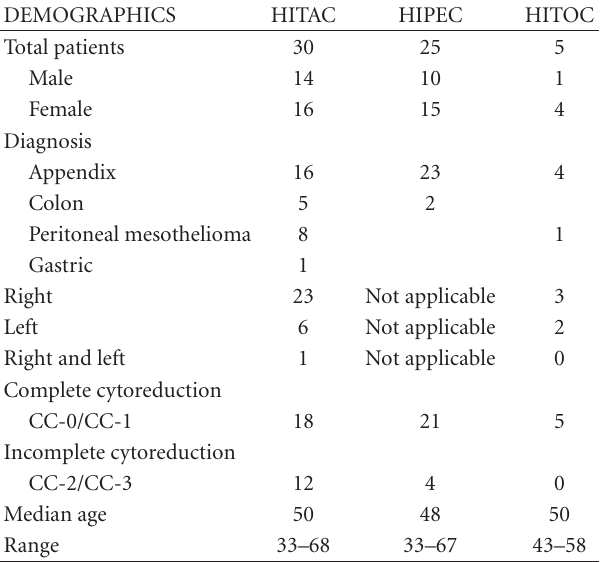
Table 1: Clinical and demographic information on patients hav- ing hyperthermic intraoperative thoracoabdominal chemotherapy (HITAC), patients having hyperthermic perioperative chemother- apy (HIPEC), and patients having hyperthermic intrathoracic chemotherapy